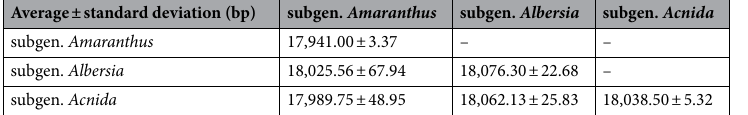
Table 2. Length differences of chloroplast genome SSC regions at the subgenus level in Amaranthus.